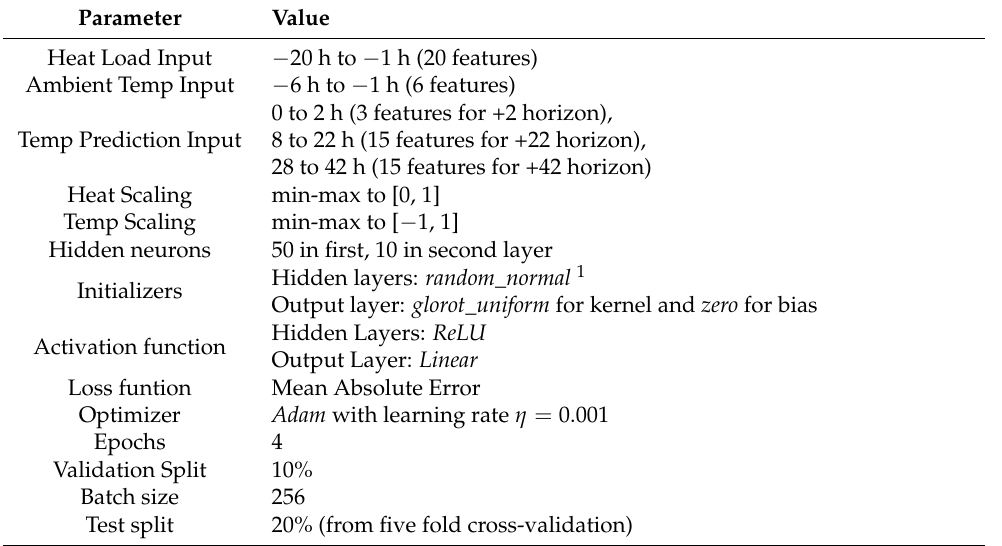
Table A1. Initial parameter set for initial model creation.